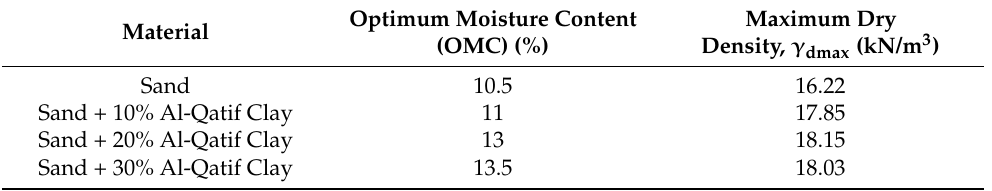
Table 4. The maximum dry density and optimum moisture content for the sand–clay